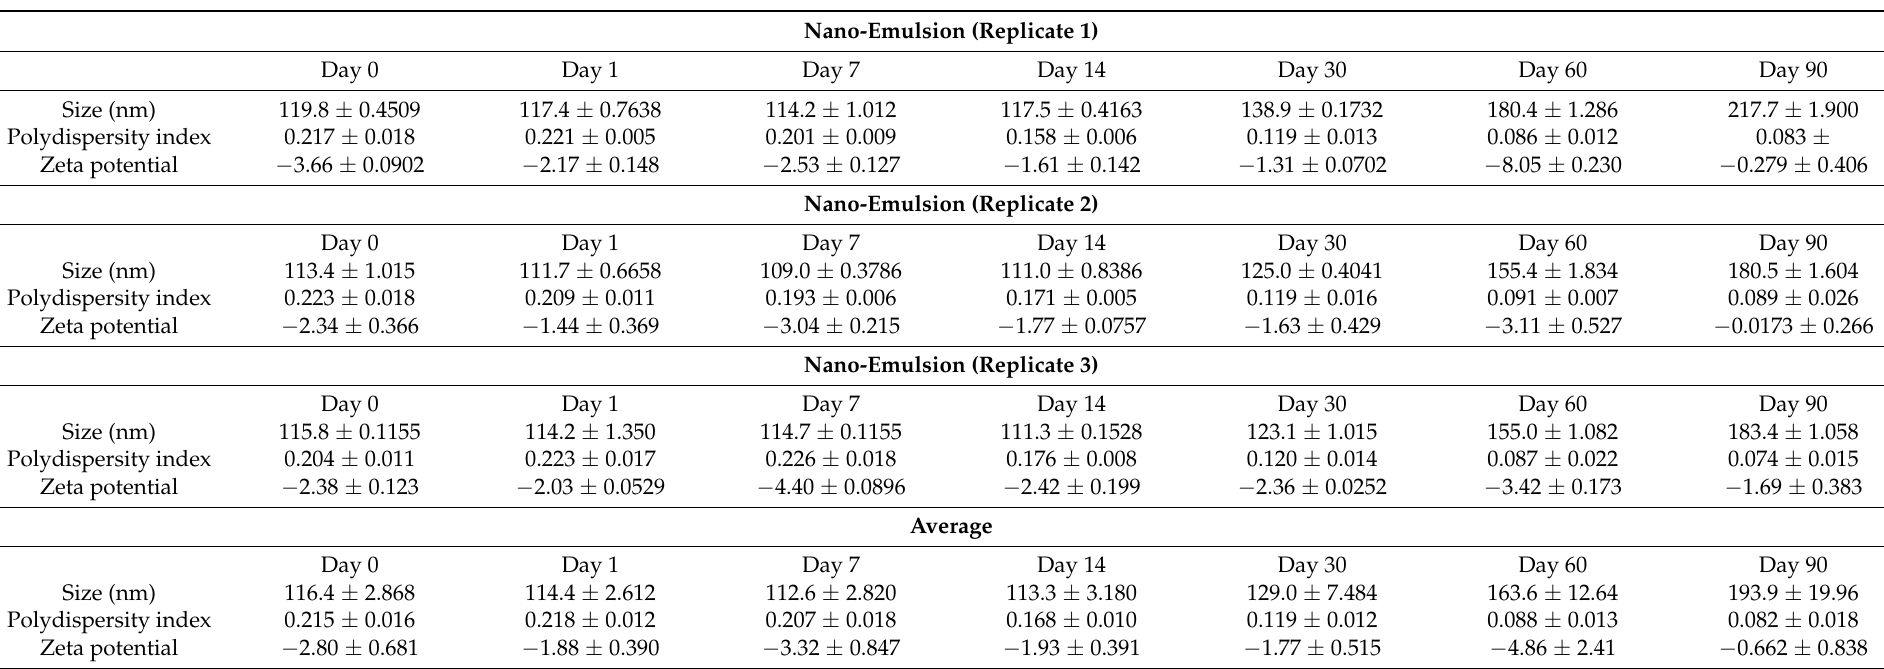
Table 2. Dynamic light scattering (droplet size and polydispersity index) and zeta potential values after preparation (day 0) and after storage of the nano-emulsions prepared with the essential oil of Pectis elongata